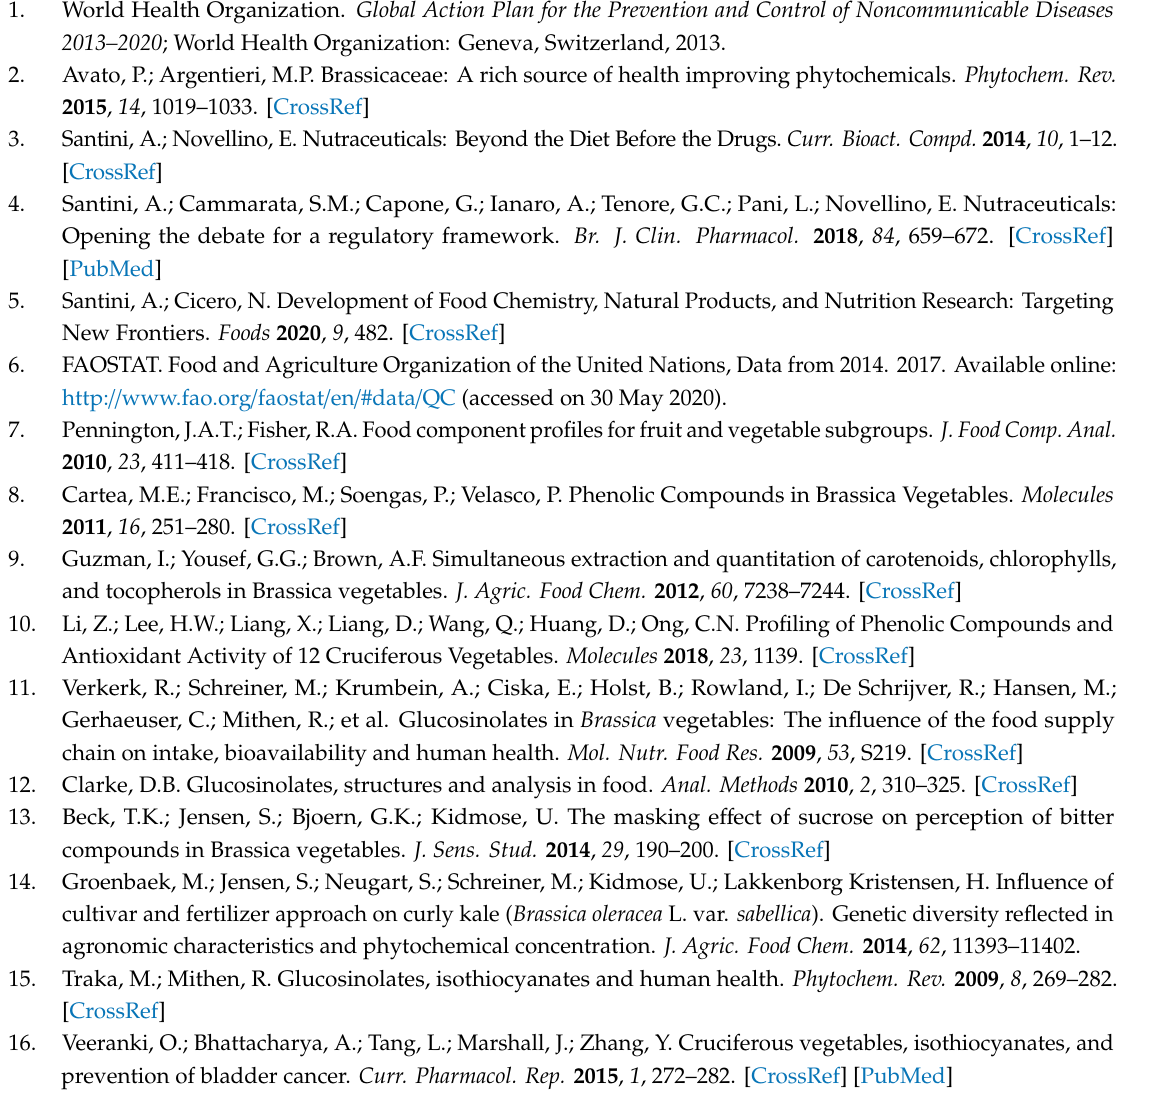
Figure S1: 1 H spectrum of Brassica oleracea var. italica hydroalcoholic extract, Figure S2: 1 H spectrum of Brassica oleracea var. italica 1 H spectrum of Brassica oleracea var. italica chloroform extract, Figure S3: 1 H- 1 H TOCSY spectrum of Brassica oleracea var. italica hydroalcoholic extract, Figure S4: 1 H- 1 H TOCSY spectrum of Brassica oleracea var. italica chloroform extract, Figure S5: 1 H- 13 C HSQC spectrum of Brassica oleracea var. italica hydroalcoholic extract, Figure S6: 1 H- 13 C HSQC spectrum of Brassica oleracea var. italica chloroform extract, Figure S7: 1 H- 13 C HMBC spectrum of Brassica oleracea var. italica hydroalcoholic extract, Figure S8: 1 H- 13 C HMBC spectrum of Brassica oleracea var. italica chloroform extract, Table S1: Metabolites identified in the 1 H NMR spectra of the Brassica oleracea var. italica